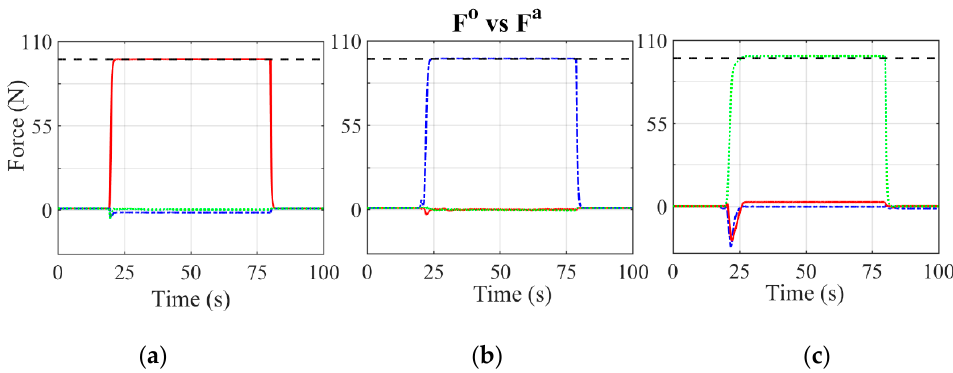
Figure 10. Measured forces ( F 0 ) in the tangential, radial and lateral-medial directions for the 10 kg calibration weight. F a is the calibration weight in N. ( a ) Calibration weight applied in tangential direction. ( b ) Calibration weight applied in radial direction. ( c ) Calibration weight applied in lateral-medial direction. Red solid line: tangential force. Blue dashed dotted line: radial force. Green dotted line: lateral-medial force. Black dashed line: calibration weight.